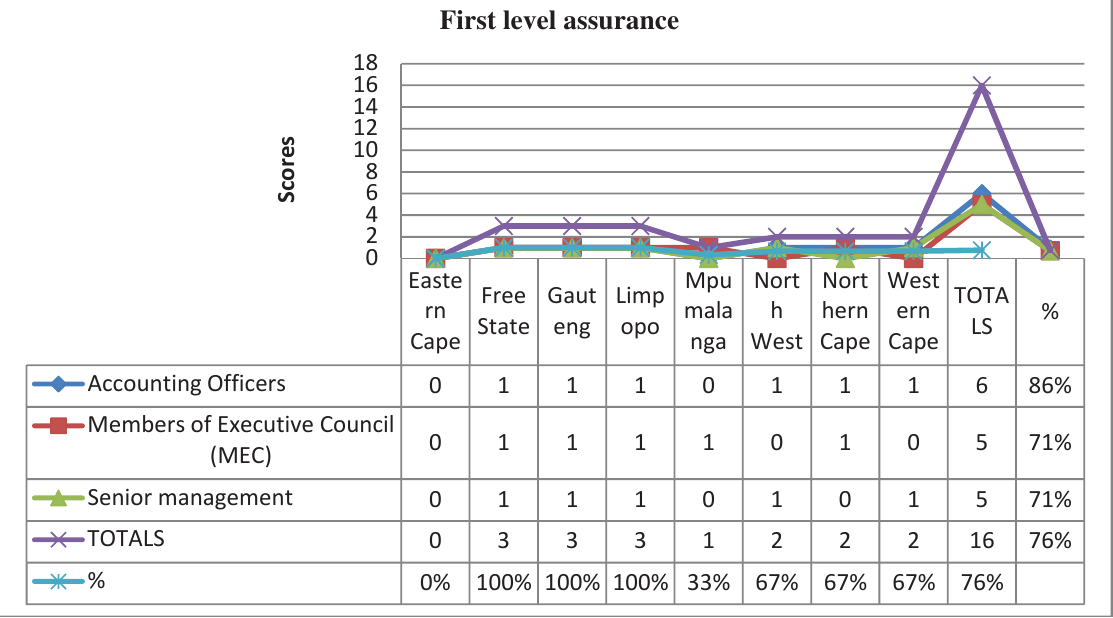
Fig. 1. First level assurance